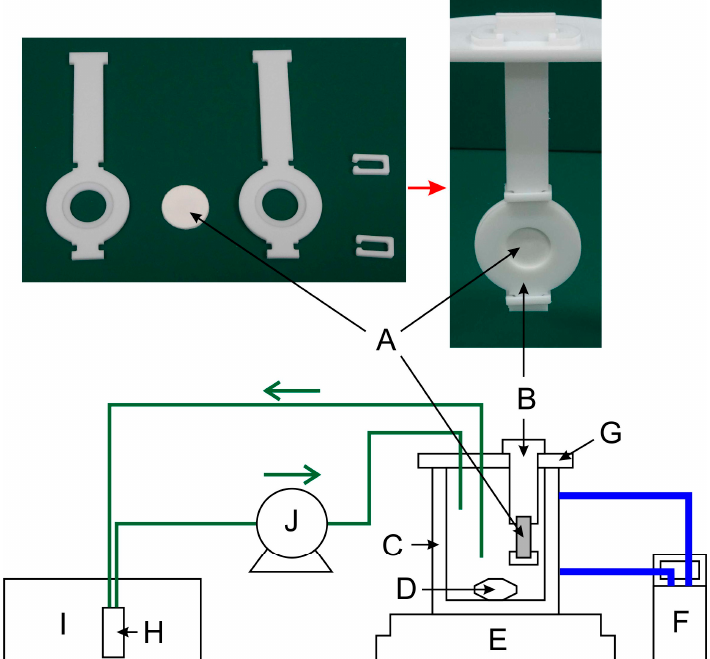
Figure 2. Schematic illustration of the set-up for drug release evaluation. A: Sample, B: Sample holder, C: Jacketed beaker, D: Stirrer bar, E: Magnetic stirrer, F: Circulating water bath, G: Beaker cap, H: Quartz flow cell, I: UV/vis spectrophotometer, and J: Peristaltic pump. 2-Morpholinoethanesulfonic acid (MES) monohydrate (CAS No. 145224-94-8) was purchased